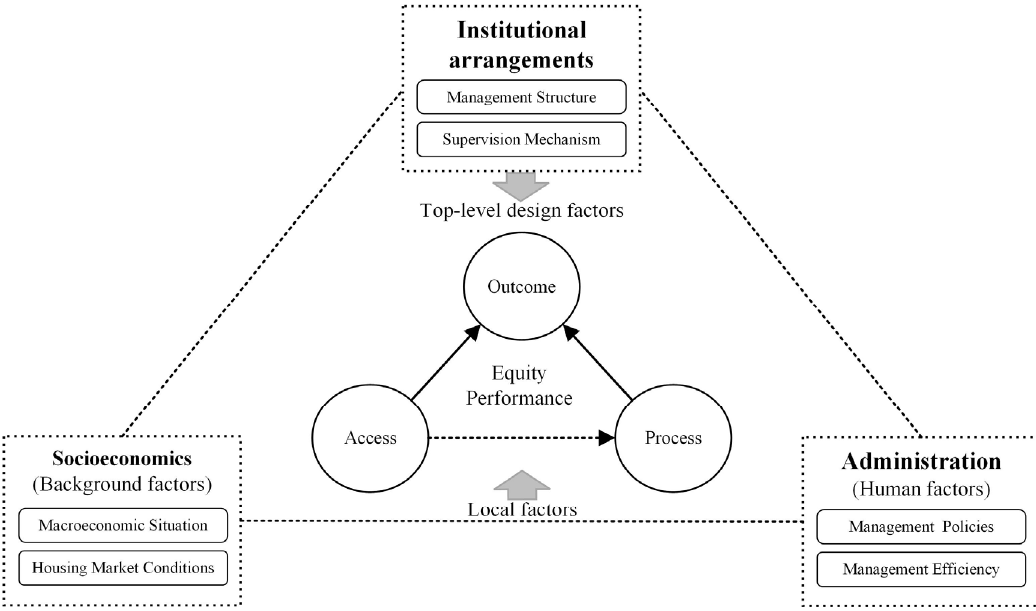
Figure 1. Conceptual framework.